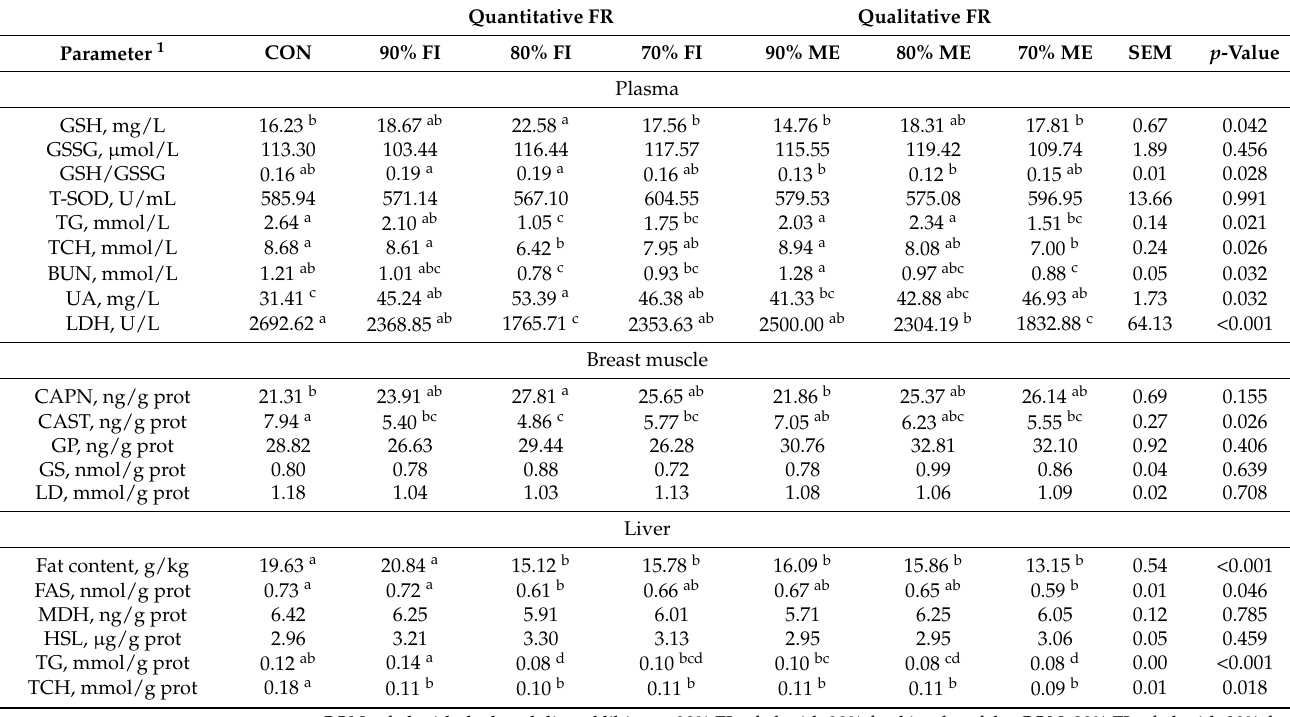
Table 3. Effects of feed restriction (FR) on plasma, breast muscle, and liver biochemical indices of Bearded chickens.